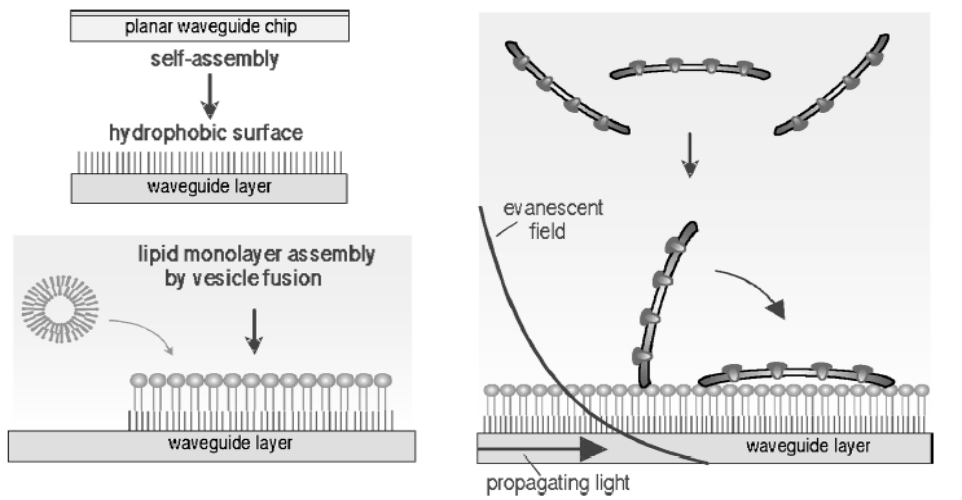
Figure 7. The concept of the functional immobilization of membrane fragments on the metal oxide waveguide. First step (left) formation of a biocompatible surface by self- assembly of a lipid-monolayer. Second (right) stable sorption of membrane fragments onto the preformed lipid interface. Reproduced from